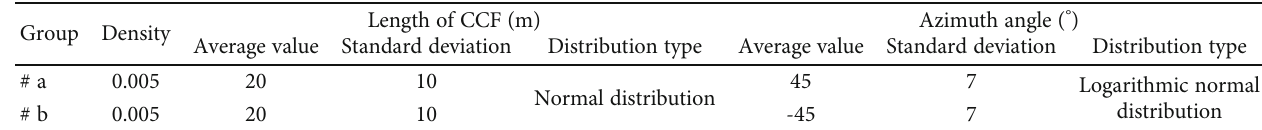
Table 3: The geometric parameters of the DFN model.